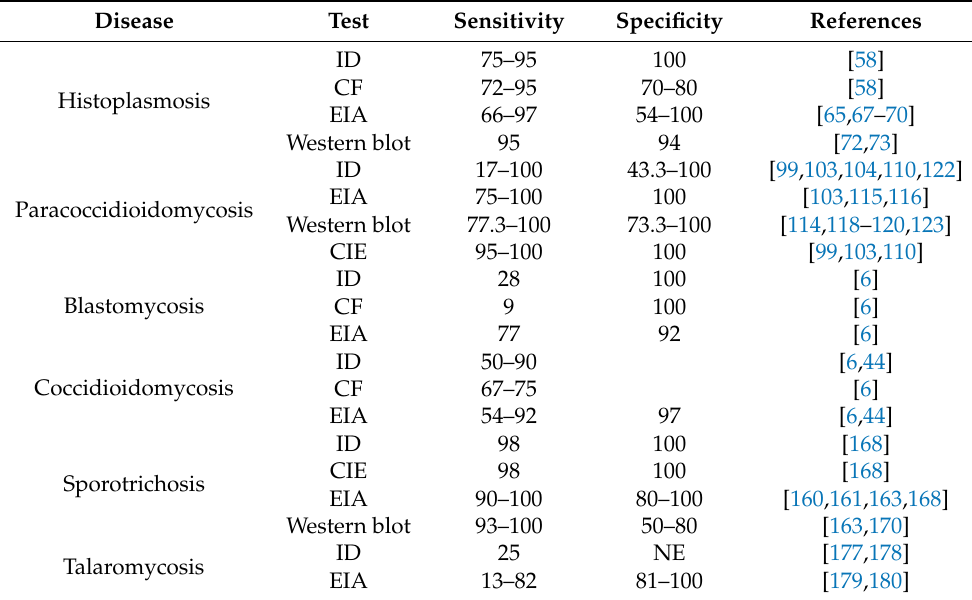
Table 2. Summary of sensitivity and specificity values of immunological tests used for diagnosis of endemic mycoses by antibody detection.